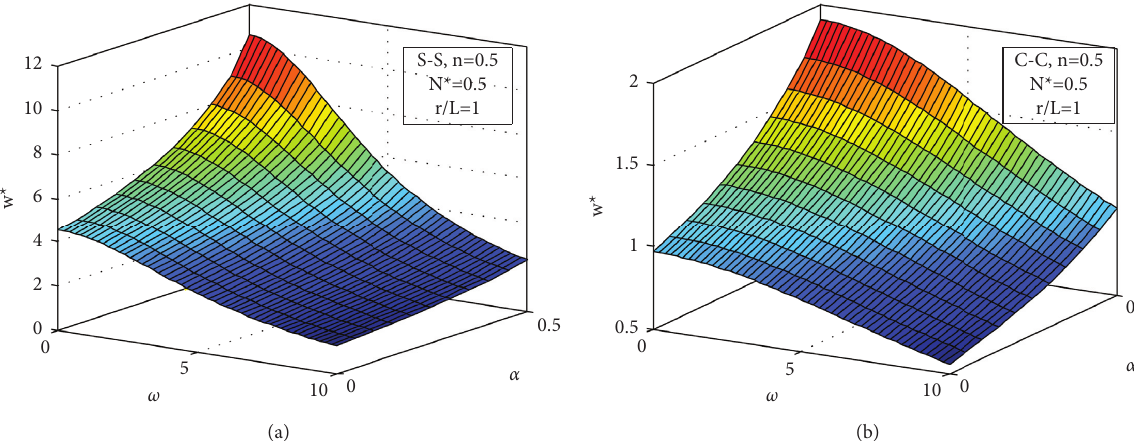
Figure 8: The nondimensional maximum deflection of the FG beam as a function of porosity volume fraction α and rotating speed, K ∗ and K ∗ s � 5. (a) S-S. (b)